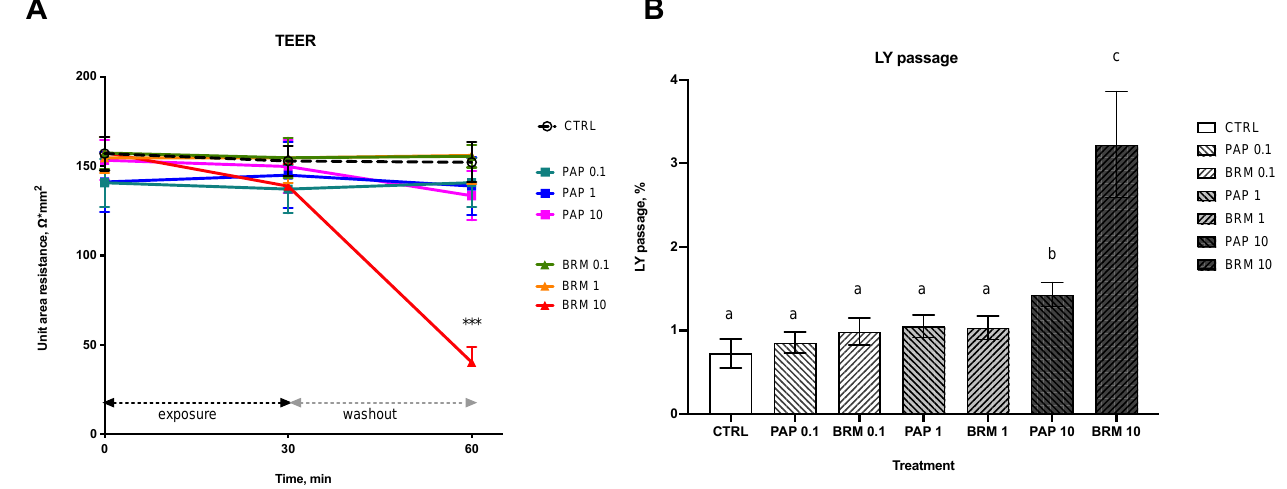
Figure 5. Bromelain and papain effect on the epithelial integrity ( A ) as measured by TEER and permeability for LY marker ( B ). Significant differences denoted by *** p < 0.001 (for A ) and with different letters–groups not sharing a common letter are significantly different from each other; p < 0.05 (for B